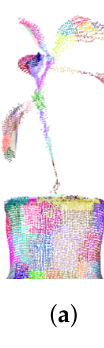
Figure 7. Segementation leaves and stem with locally convex connected patches method (LCCP) algorithm. ( a ) Segementation plant’s point cloud into small regions. ( b ) Small regions into larger objects by convexity-concavity relationship.